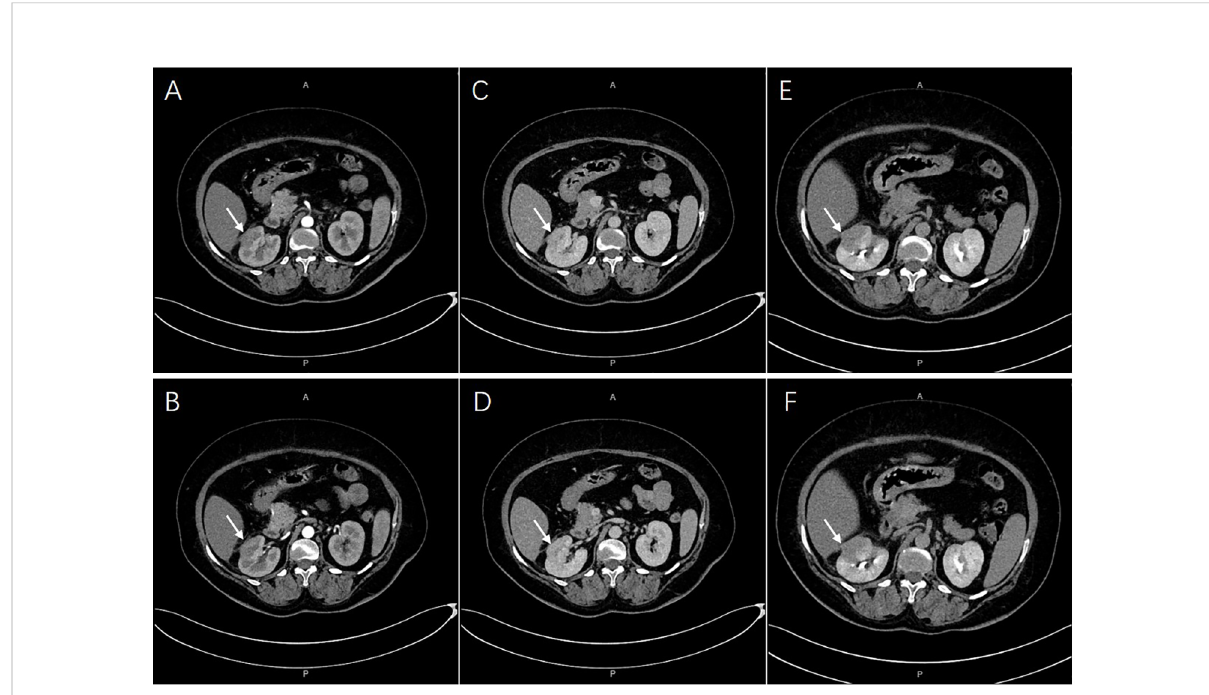
FIGURE 1 A multiple low-density lesions at right kidney. The enhancement degree was similar with renal parenchyma both in arterial [ (A, B) , arrows] and venous phases [ (C, D) , arrows]. Lower enhancement in excretory phase were imaged [ (E, F) ,